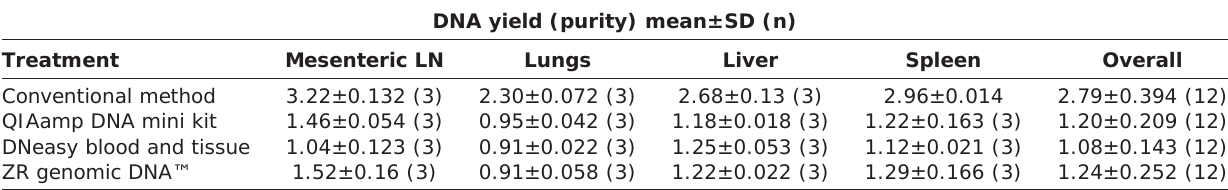
Table-2: Analytical DNA yield in mesenteric lymph node, lungs, liver and spleen, express as μ g DNA/mg of tissue. Fixation time of 3 days followed by conventional method and commercial Kit